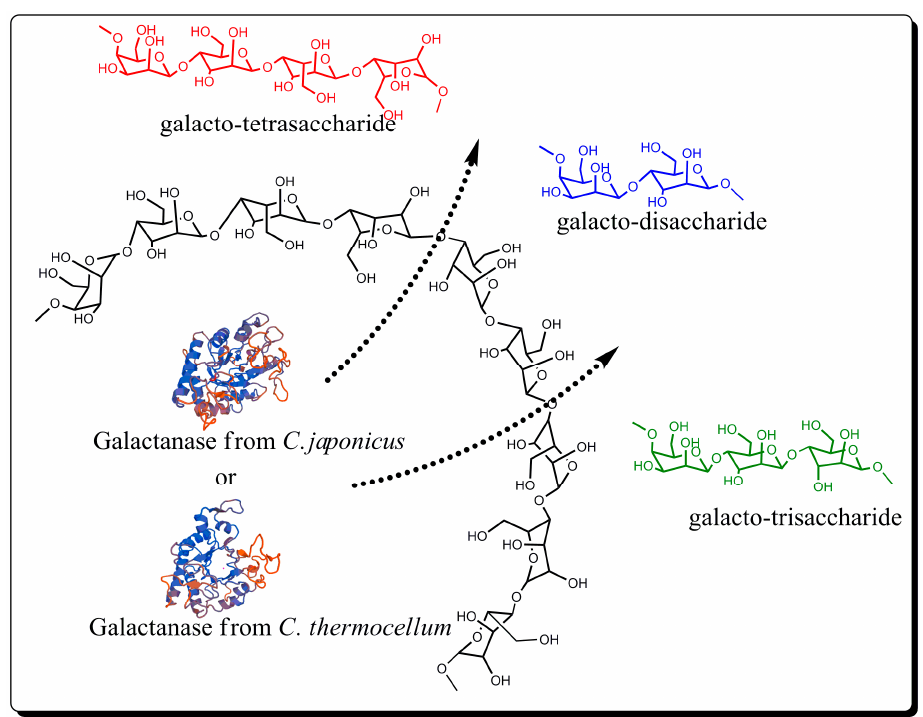
Figure 1. Scheme of pectic galactan-oligosaccharide production via enzymatic hydrolysis.